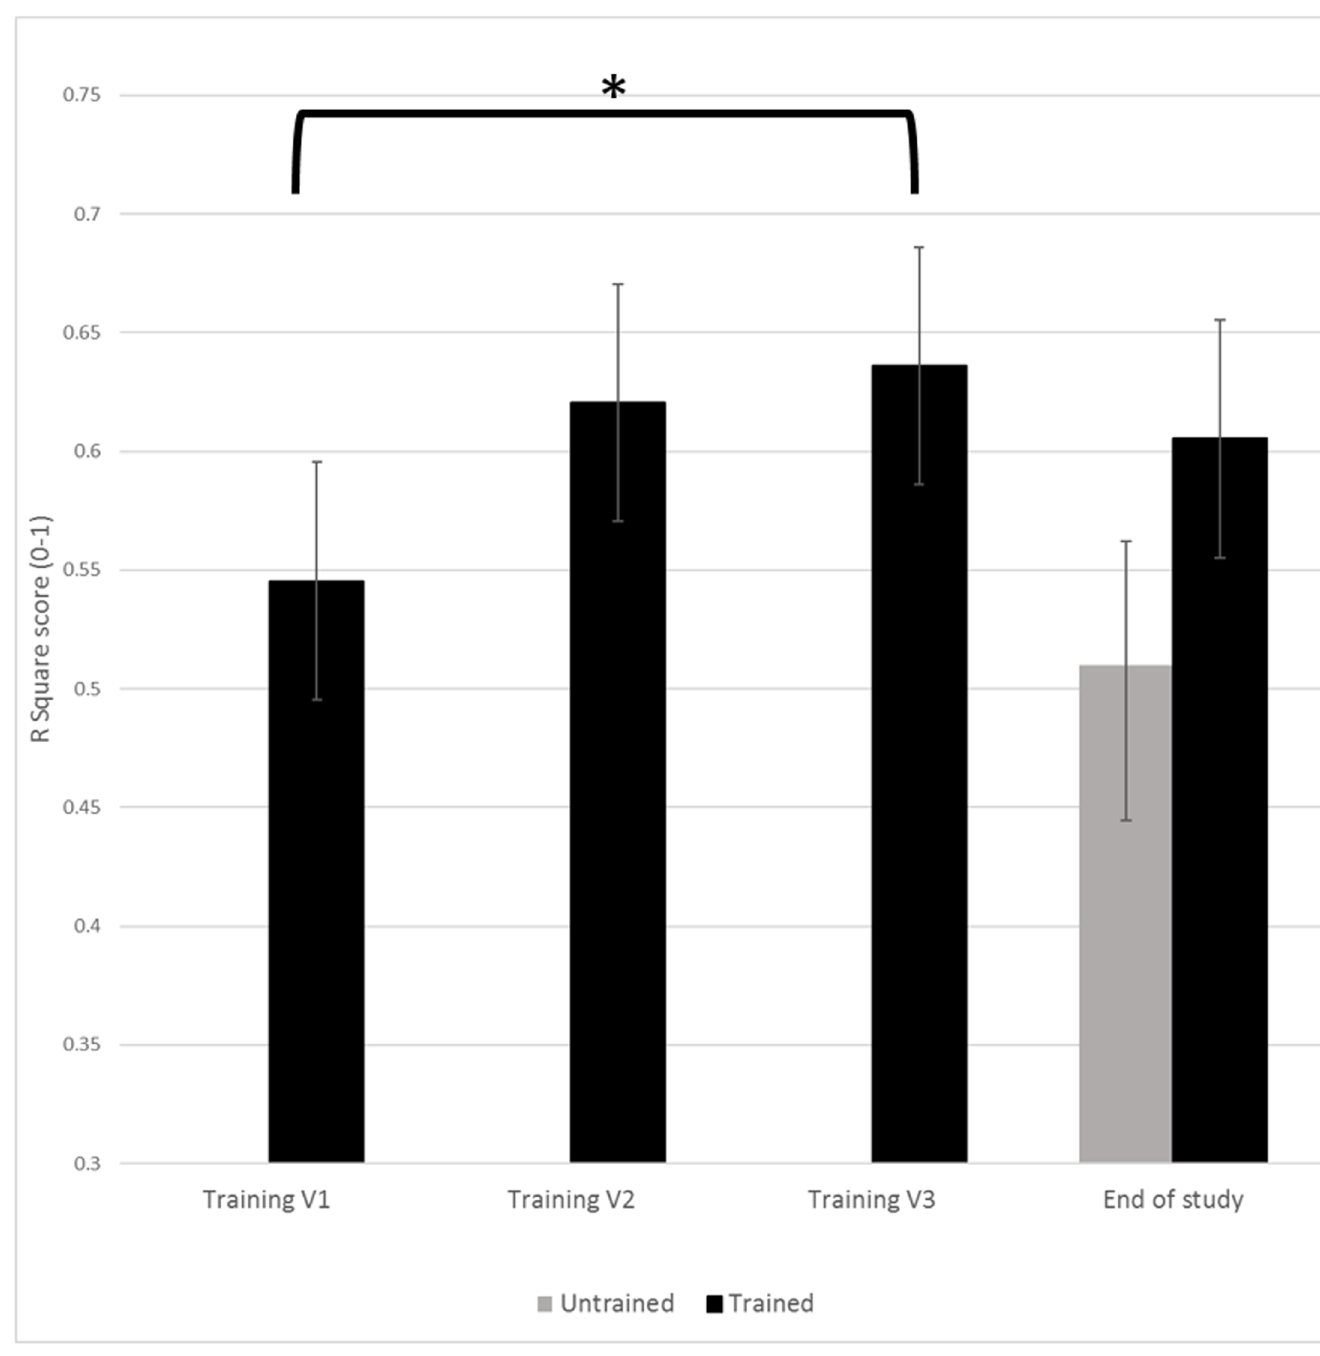
Fig 3. Improved experimental pain reporting accuracy. (cid:3) = P <